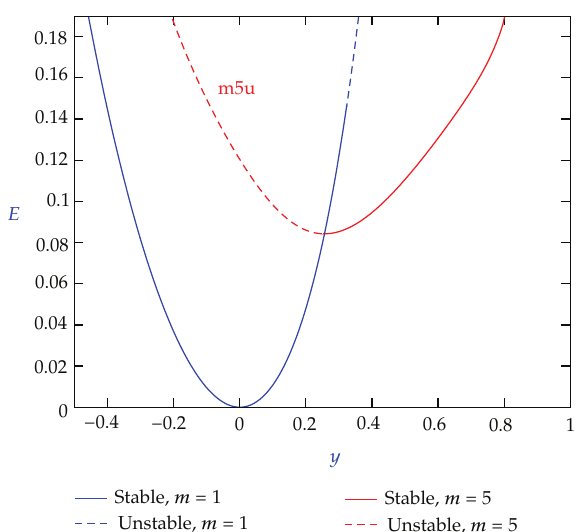
Figure 3: Continuation of two families of periodic orbits (cid:3) multiplicities m (cid:8) 1 and 5 (cid:4) of the classical H´enon- Heiles Hamiltonian with x 0 (cid:8) Y 0 (cid:8) 0 depending on the coordinate y and the energy E . Table 1: CPU times for the computation of the unstable branch of the family with multiplicity 5 (cid:3) m5u (cid:4) in Figure